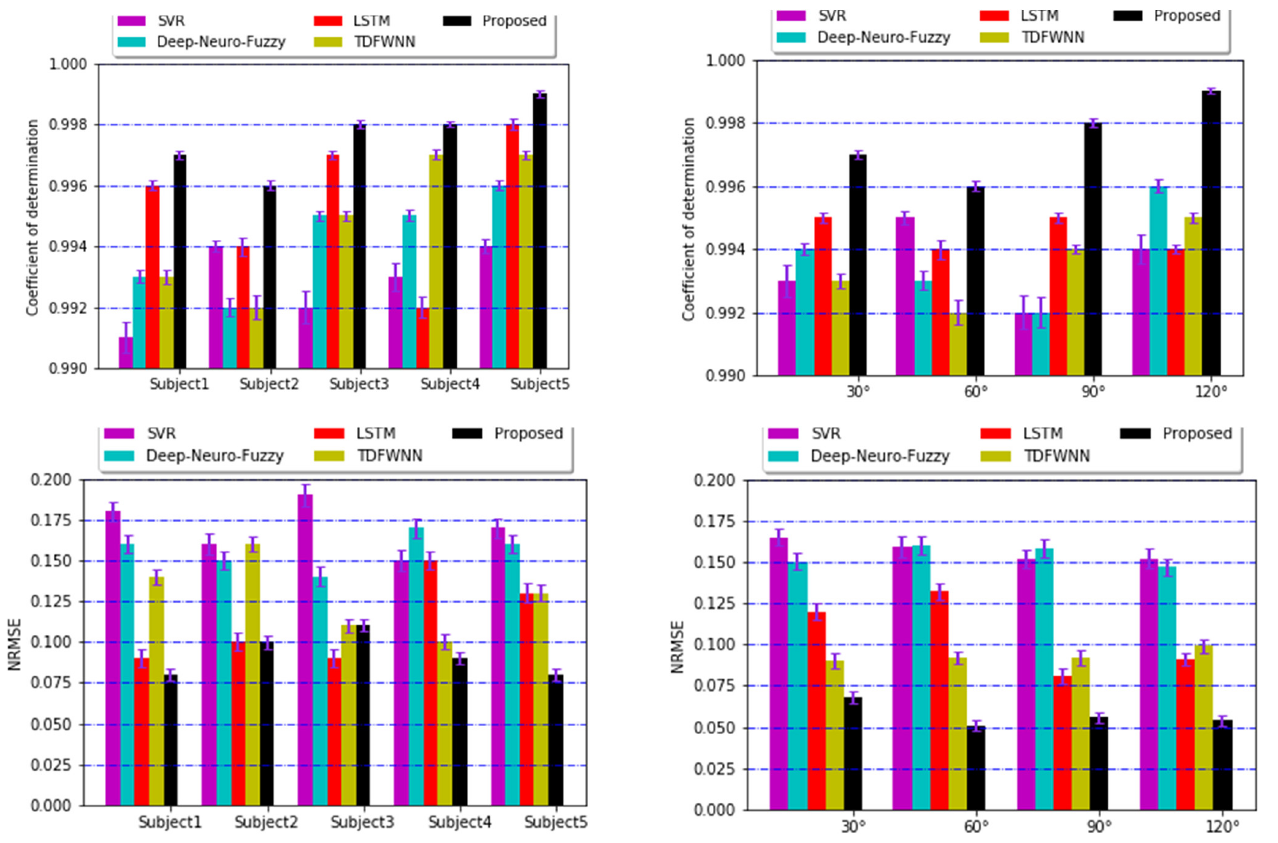
Figure 12. Accuracy comparison of different algorithms (NRMSE and Coefficient of determination).